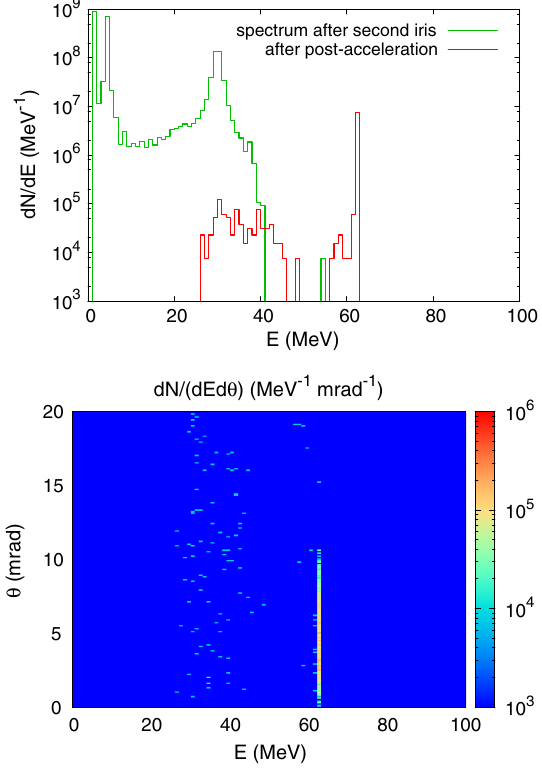
FIG. 9. Upper frame: Energy spectra for a bunch with initial energy of 30 MeV (cid:6) 0 : 1 MeV (green line) postaccelerated in one module of ACLIP (red line). Lower frame: Postacceleration